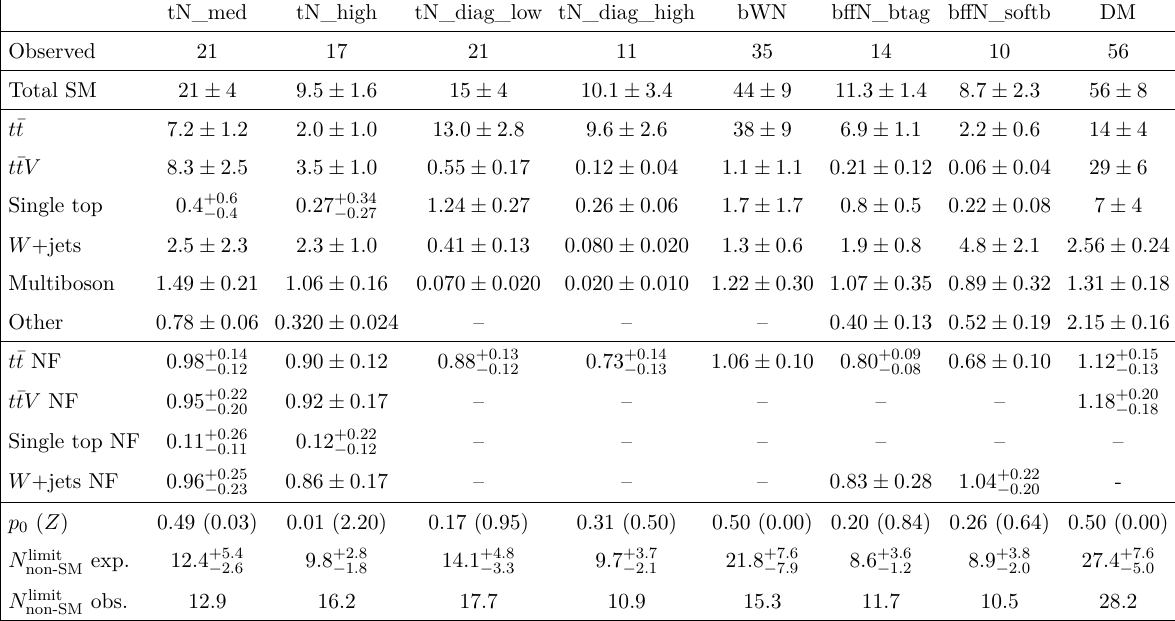
Table 14. The number of observed events in the various SRs together with the expected numbers of background events and their uncertainties as predicted by the background-only fits, the normalisation factors for the background predictions obtained in the fit, the probabilities (represented by p 0 and Z values) that the observed numbers of events are compatible with the background-only hypothesis, and the expected ( N limit exp.) and observed ( N limit obs.) 95% CL upper limits on the number non-SM non-SM of beyond-SM